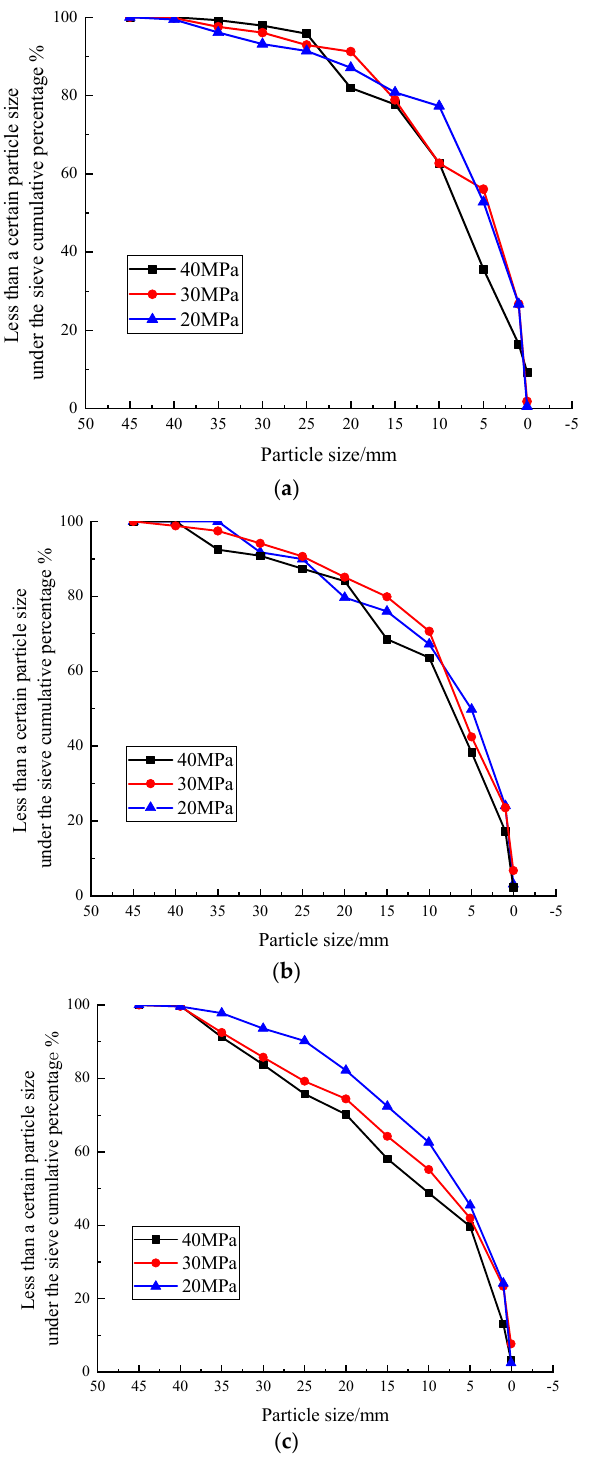
Figure 12. Particle size distributions of fragments under different amplitudes of disturbance: ( a ) Gra60%; ( b ) Gra70%; ( c ) Gra80%.